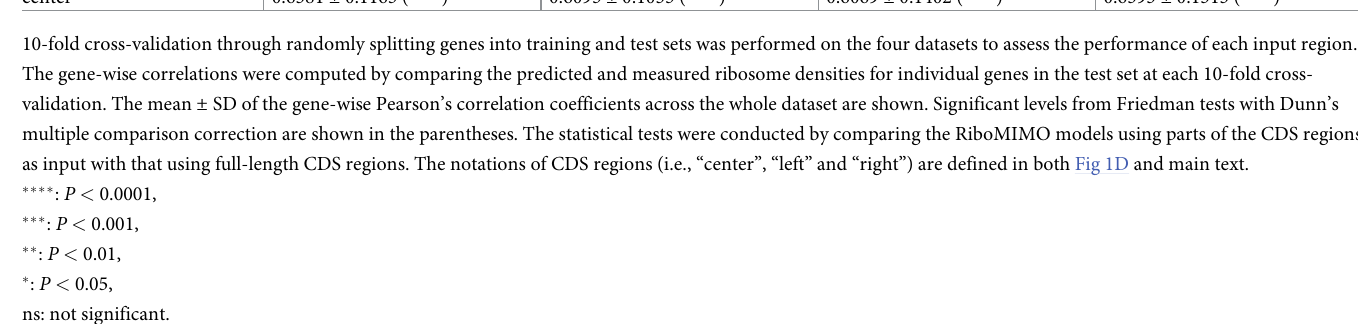
Table 3. Performance evaluation of RiboMIMO with different CDS regions as input, measured in terms of Pearson’s correlation coefficient.